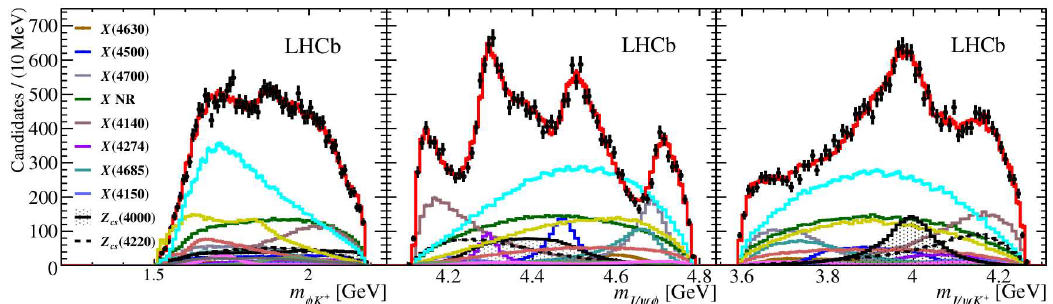
Figure 3: The fit is shown for three different mass pairs; φ K + , J /ψφ , and J /ψ K + from left to right respectively. The contributions from each of the resonances is shown, with the total fit shown by the solid red